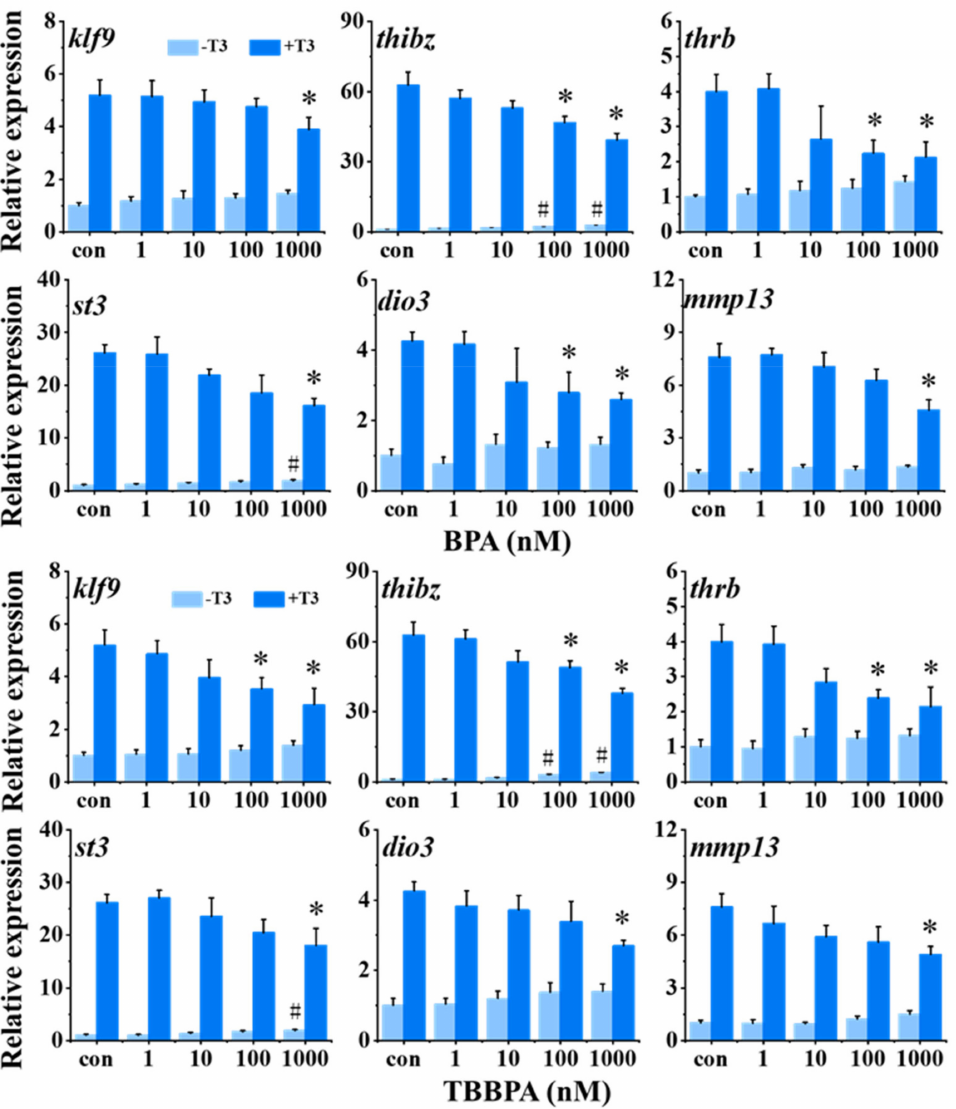
Figure 2. Relative expression of thyroid hormone (TH)-response genes in stage 48 Xenopus tadpoles following 24-h exposure to bisphenol A (BPA) and tetrabromobisphenol A (TBBPA) in the absence or presence of 1 nM T3. Data are shown as mean ± SEM ( n = 3). * and # indicate significant differences between BPA or TBBPA exposure and the control and between BPA or TBBPA + T3 and T3 treatment, respectively ( p < 0.05). klf9: Kruppel-like factor 9; thibz: thyroid hormone induced bZip protein; thrb: thyroid hormone receptor beta; st3: stromelysin-3; dio3: type 3 deiodinase; mmp13: matrix metallopeptidase 13